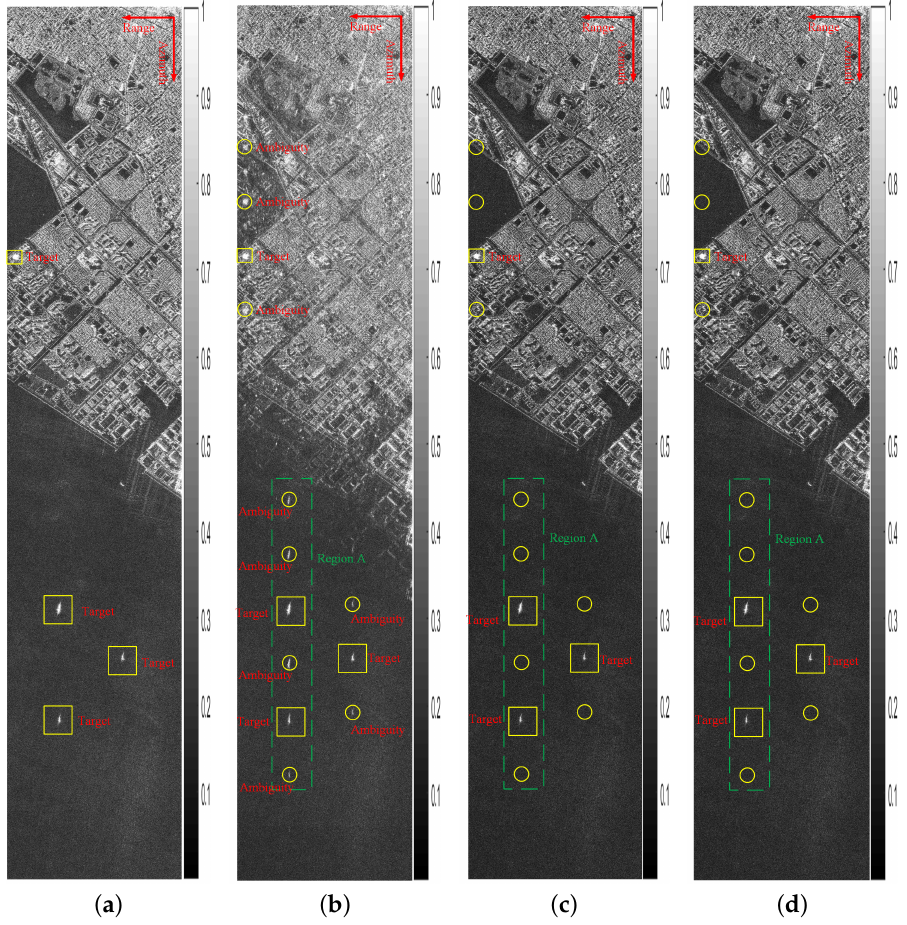
Figure 16. Imaging results of the distributed scene (by amplitude normalization). ( a ) Reconstruction result without errors; ( b ) reconstruction result by IDR with errors; ( c ) reconstruction result by SILAMER with errors (by using the whole scene of the sub-images); ( d ) reconstruction result by SILAMER with errors (by using the local area of the sub-images).